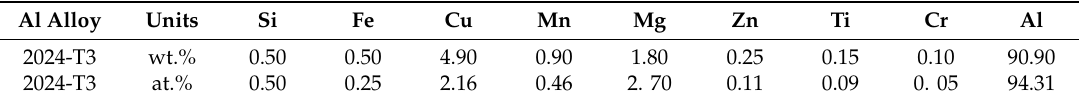
Table 3. Chemical composition of the aluminum alloy 2024-T3, as provided by the manufacturer (Kaiser Aluminum, Spokane, WA, USA).